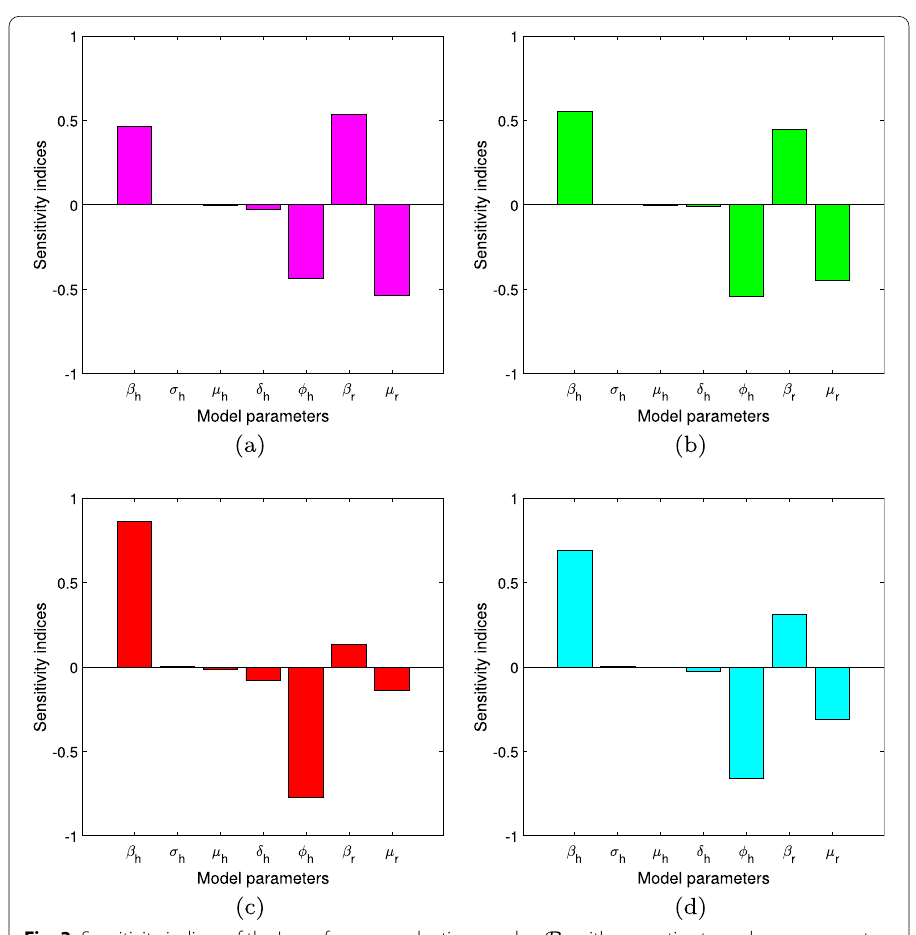
Fig. 3 Sensitivity indices of the Lassa fever reproduction number R 0 with respective to each year parameter value : a 2018 parameter values as given in Table 2; b 2019 parameter values as given in Table 2; c 2020 parameter values as given in Table 2; d Mean parameter values as given in Table 2